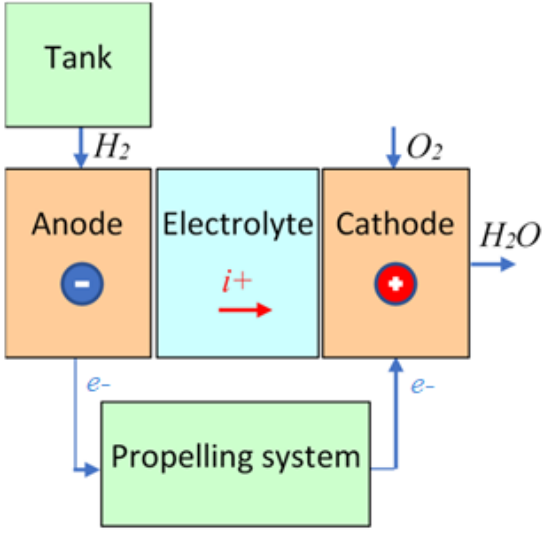
Figure 4. Scheme of a fuel cell.